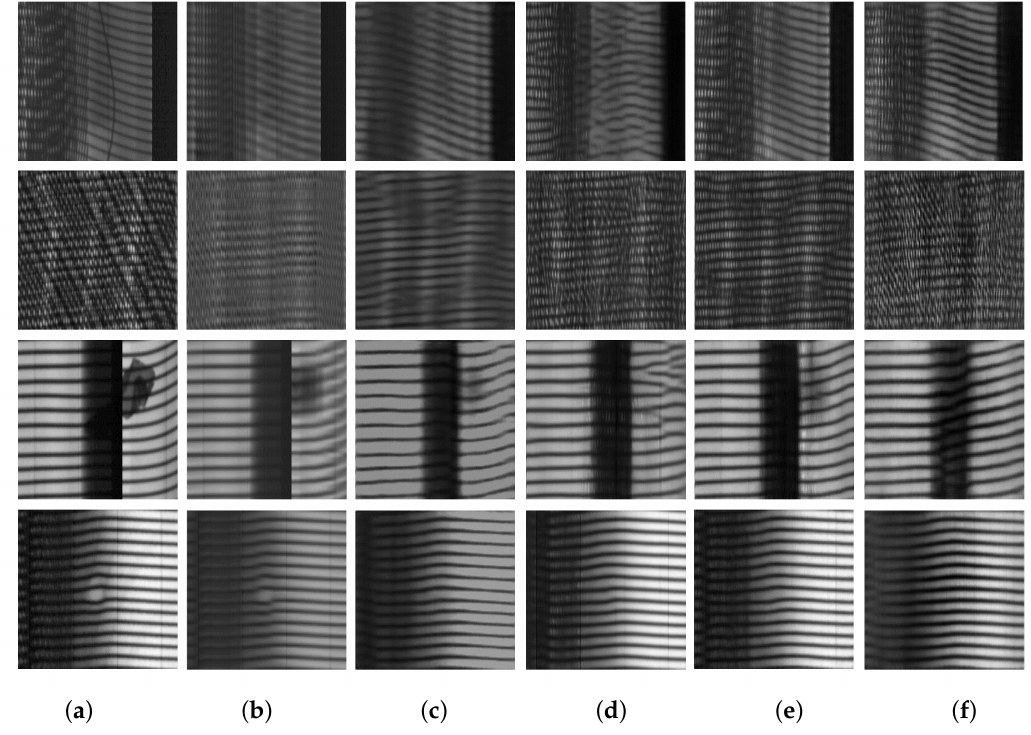
Figure 12. Images from top to bottom are defects of 0-Degree-Scatter, Belt-Joint-Open, Foreign Matter, and Blister, respectively. Images from left to right, are the ( a ) original images and reconstruction results of the model ( b ) PCA, ( c ) AE, ( d ) GAN, ( e ) GAN-Mem, and ( f )